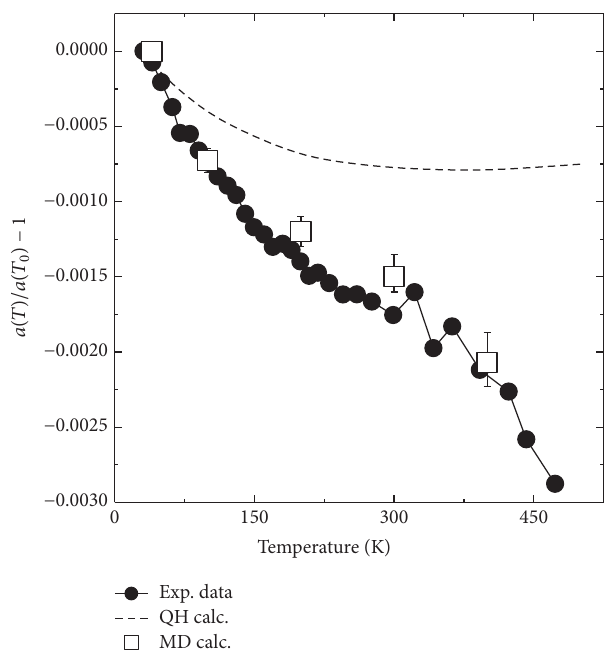
Exp. data QH calc. Figure 5: Temperature dependence of lattice parameter of Ag 2 O from experimental data in [41], quasiharmonic calculations, and MD calculations, expressed as the relative changes with respect to their 40 K values, that is, 𝑎(𝑇)/𝑎(40 K ) − 1 .